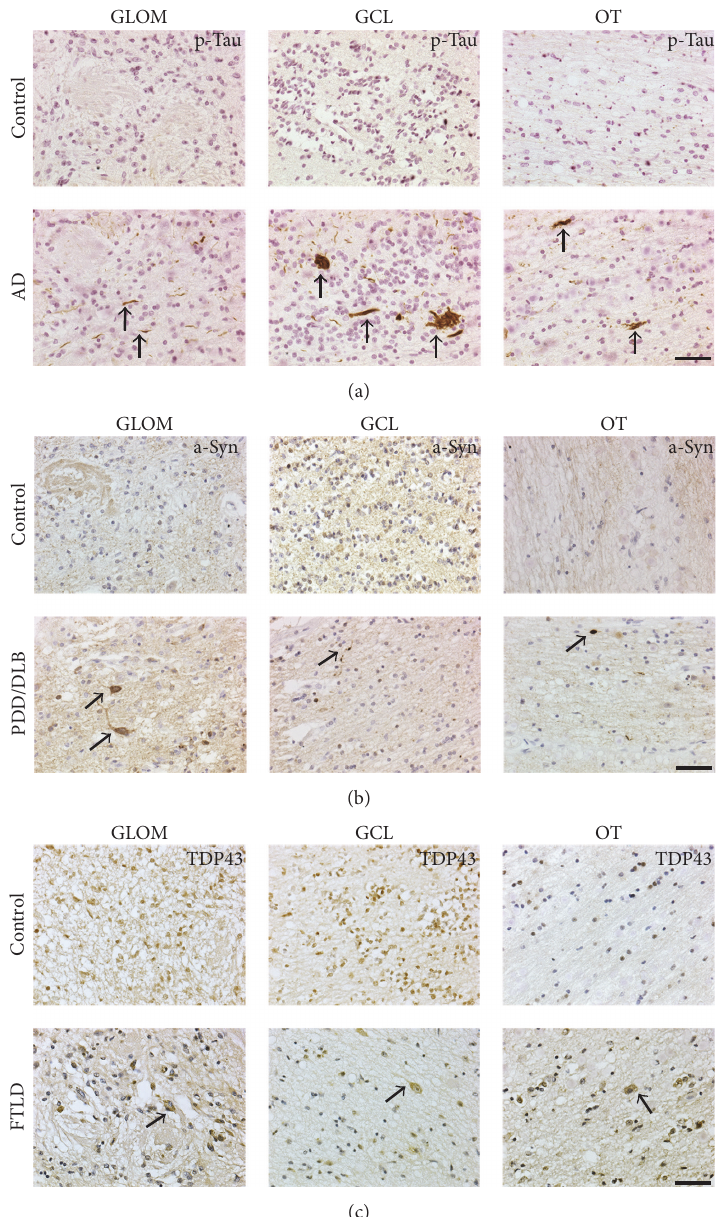
Figure2:TypicalneuropathologicalhallmarksofAlzheimer’sdisease(AD),Parkinsondiseasedementia/Lewybodydisease(PDD/DLB),and frontotemporal lobe degeneration (FTLD) in the GLOM, the GCL, and the OT compared to controls. (a) Aggregates of hyperphosphorylated Tau (p-Tau; brown) were present in all regions analyzed in AD cases. (b) Accumulation of alpha-synuclein (a-Syn; brown) was detected in the GLOM, the GCL, and the OT of PDD/DLB cases, but not in controls. (c) While controls showed a physiological nuclear staining for unphosphorylated TDP43 in all regions investigated, a shift of TDP43 signal (brown) from the nucleus to the cytoplasm, together with a loss of nuclear staining, was observed in the GLOM, GCL, and OT in FTLD. Counterstain with diluted hematoxylin or hemalaun (blue). Scale bars represent 50 𝜇